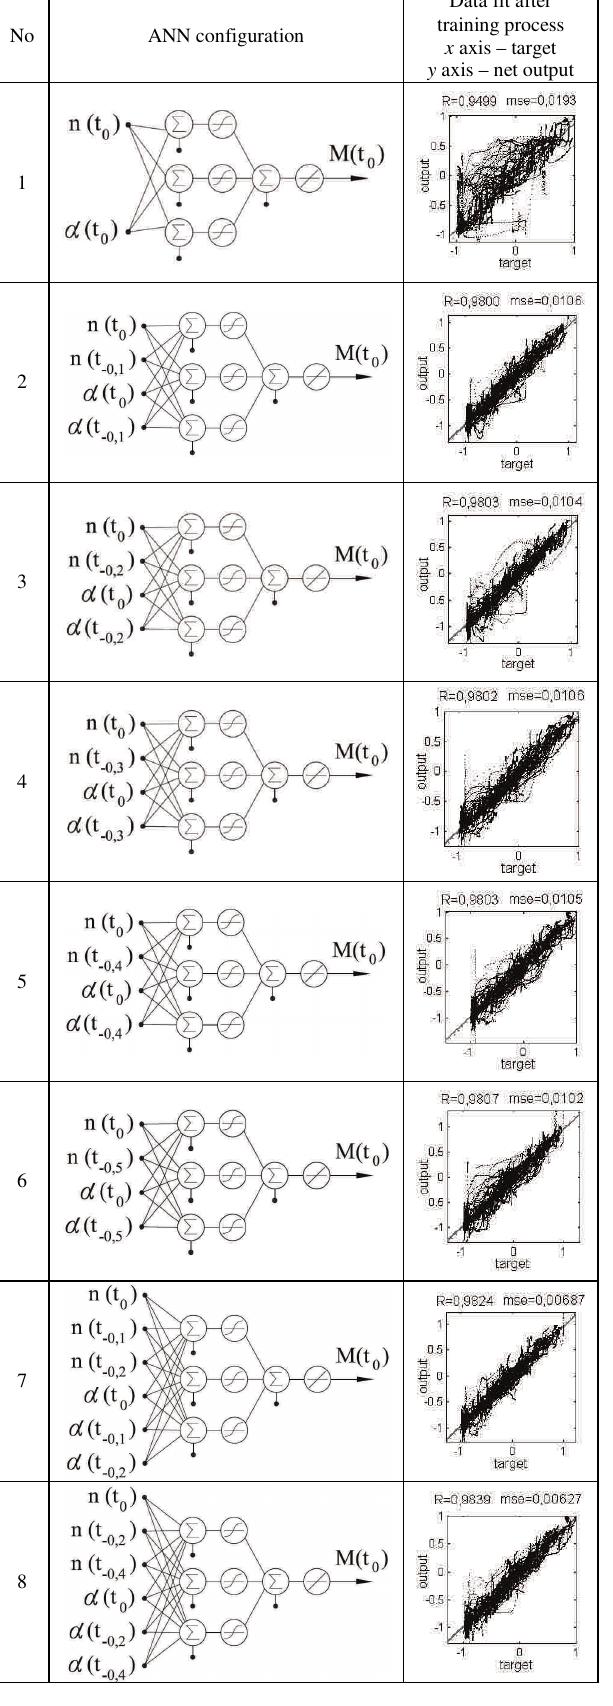
Table 1. Considered configurations of ANN architectures and corresponding mse and R values No